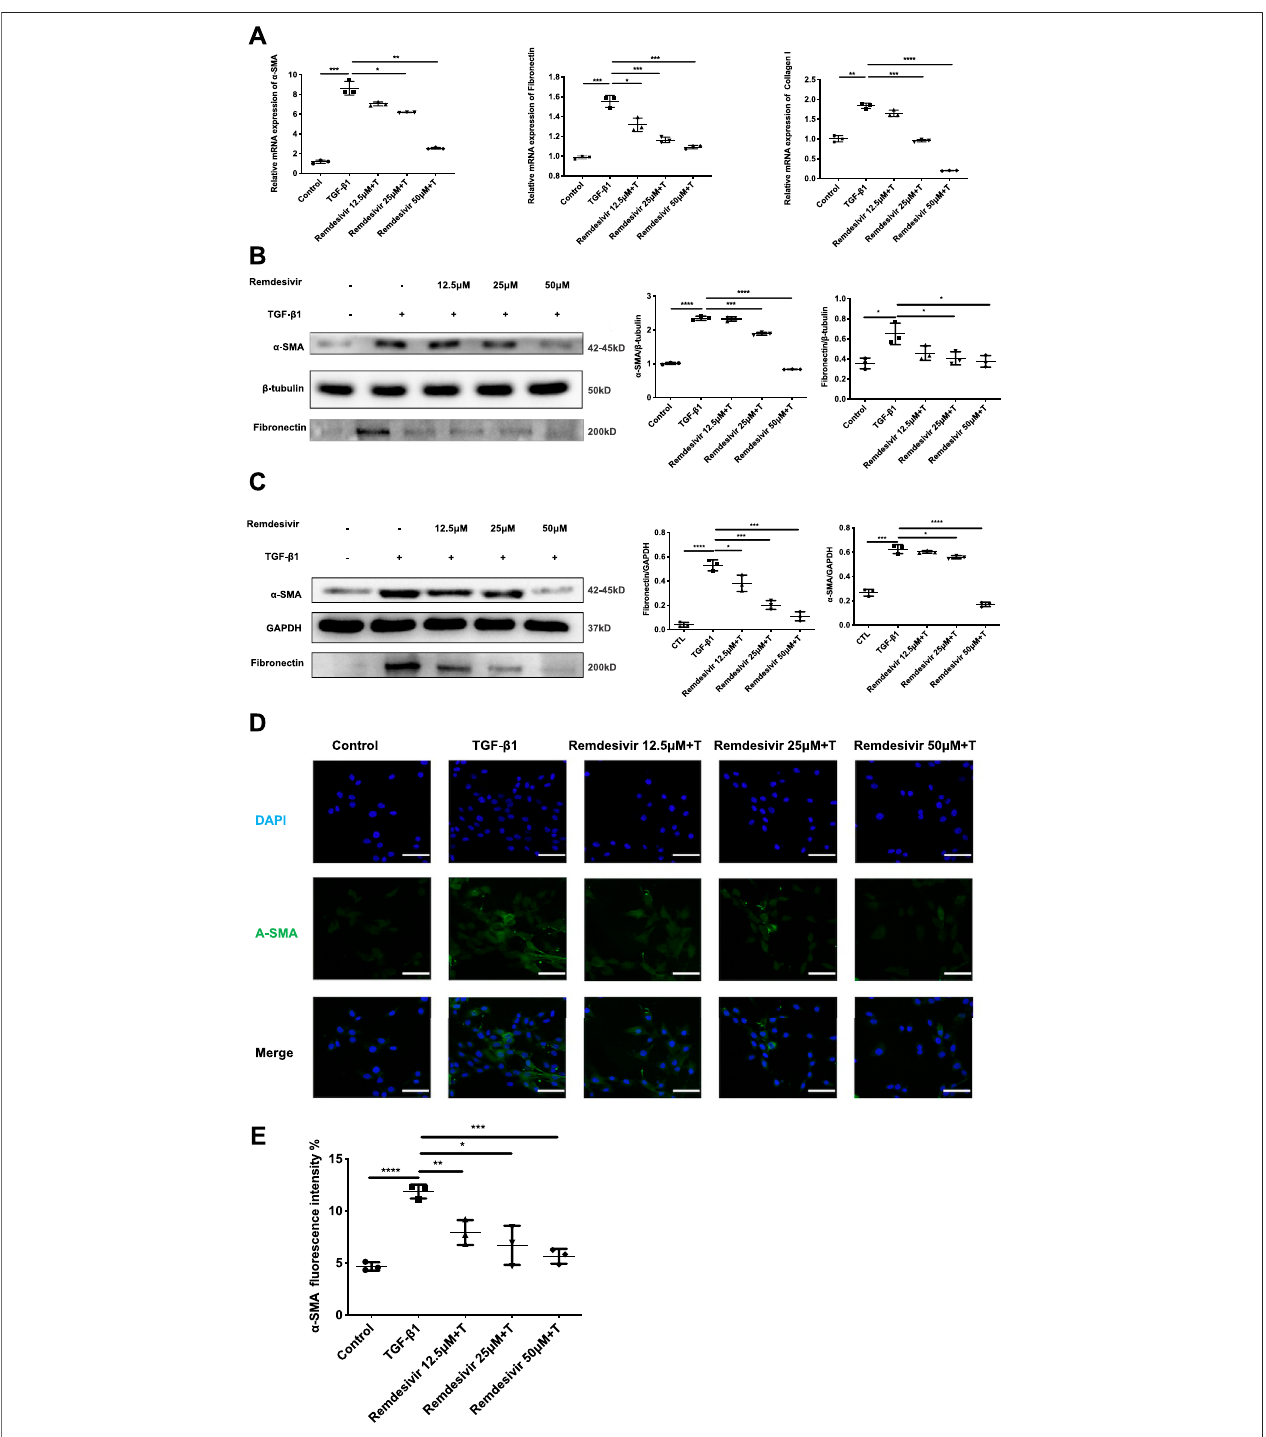
FIGURE5| RemdesivirattenuatesTGF- β 1-inducedactivationoflung fi broblasts. (A) NIH-3T3cellswereco-treatedwithTGF- β 1(5 ng ml − 1 )andRemdesivir(12.5, 25, 50 μ M) for 24 h. mRNA levels of α -SMA, Fibronectin and Collagen I were tested by RT-PCR in NIH-3T3 cells (B) NIH-3T3 cells were co-treated with TGF- β 1 (5 ng ml − 1 ) and Remdesivir (12.5,25, 50 μ M) for 24 h. α -SMA and Fibronectin were assessed using western blot, GAPDH was used asthe internal control (C) PPF cells wereco-treated withTGF- β 1(5 ng ml − 1 )andRemdesivir(12.5,25,50 μ M) for24 h. α -SMAand Fibronectin wereassessed using westernblot, β -tubulinwasused astheinternalcontrol (D) Immuno fl uorescencestainingof α -SMAwereperformedonNIH-3T3cellstreatedwith/withoutTGF- β 1(5 ng ml − 1 )and/orRemdesivir(12.5,25, 50 μ M) for 24 h. Data was noted as the means ± SD, n (cid:1) 3. * p < 0.05, ** p < 0.01, *** p < 0.001, **** p < 0.0001.